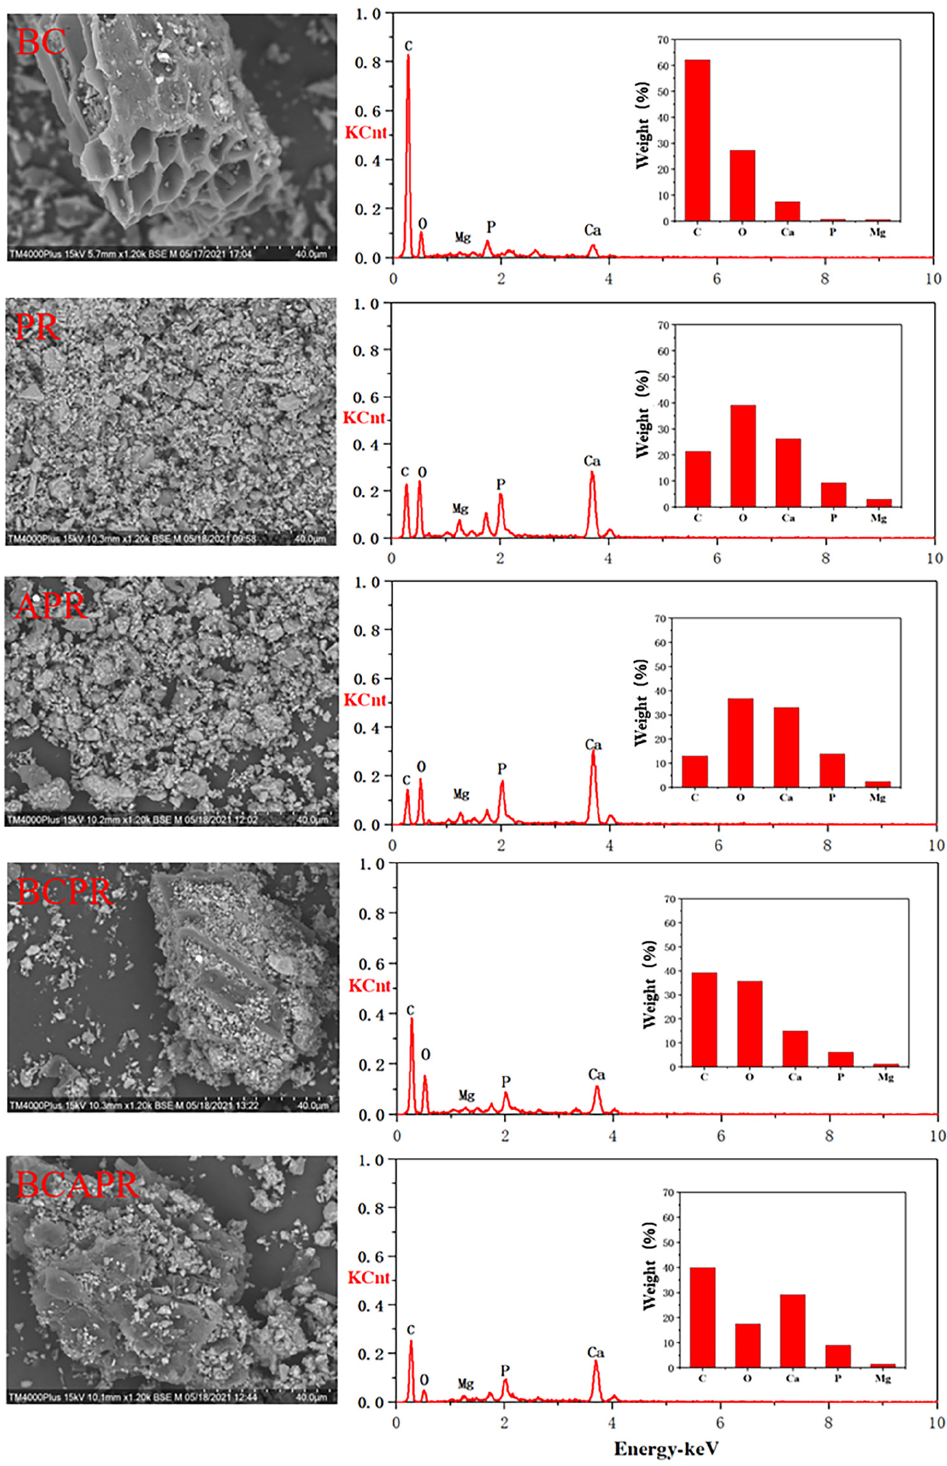
Figure 1. SEM images and the corresponding EDS spectra of the different amendments. The number of replicates was three. KCnt represented 1000 counts. BC: biochar, PR: phosphate rock, APR: activated phosphate rock, BCPR: composite of biochar and phosphate rock, BCAPR: composite of biochar and activated phosphate rock.